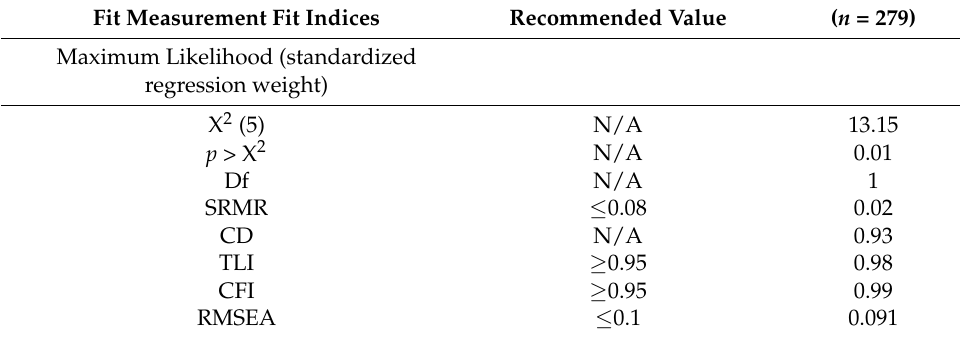
Table 3. Model Evaluation Overall Fit Measurement for the Hebrew Version of MDAS, data analyzed with STATA